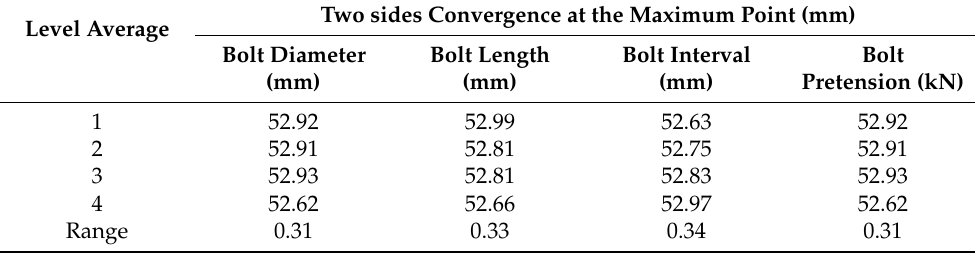
Table 7. Results and analysis of two sides convergence under four different factors. Level Table 8. Results and analysis of the plastic yield zone under four different influencing factors.